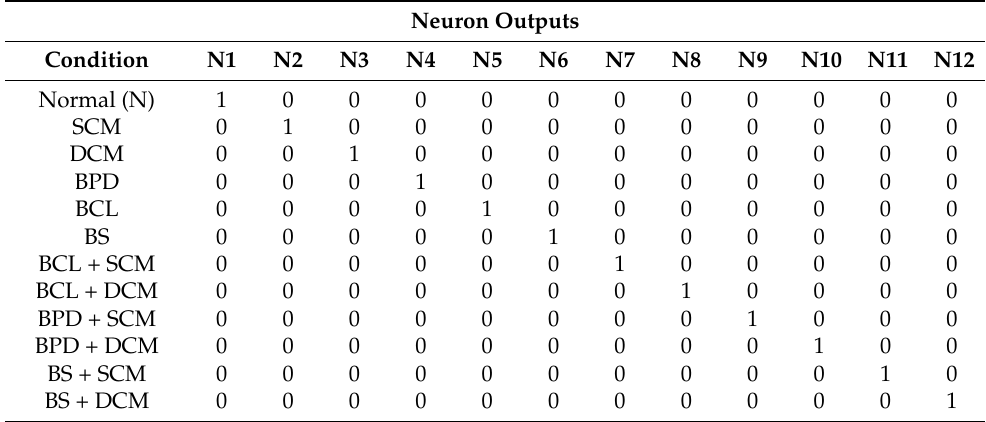
Table 2. Representation of fault